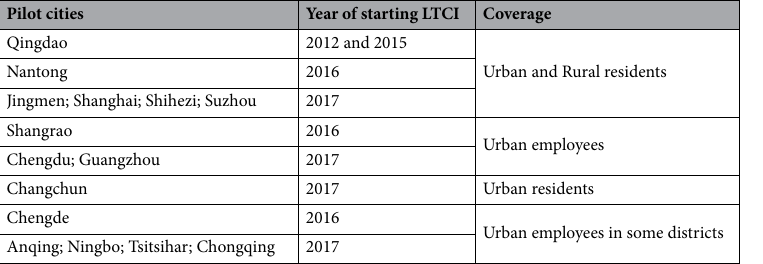
Table 1. Details on the execution of LTCI in pilot